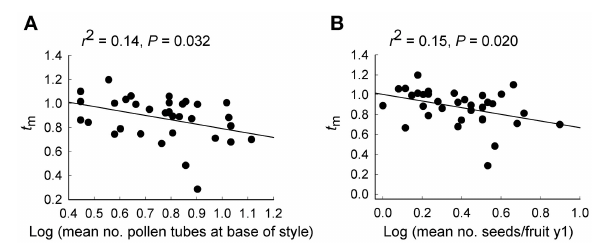
FIGURE 4 | Relationship of the multilocus outcrossing rate ( t m ) with (A) the number of pollen tubes at the base of the style and (B) the number of seeds per fruit, for 35 maternal Eucalyptus wandoo plants. Regression lines are presented with r 2 - and P -values.